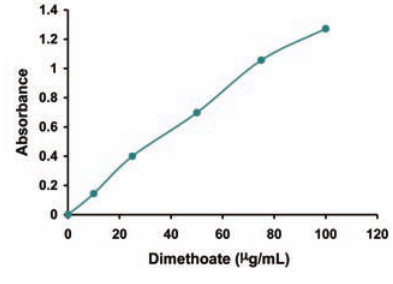
isolates.Figure 1. Standard curve for the estimation of dimethoate at 505 nm. The regression equation is